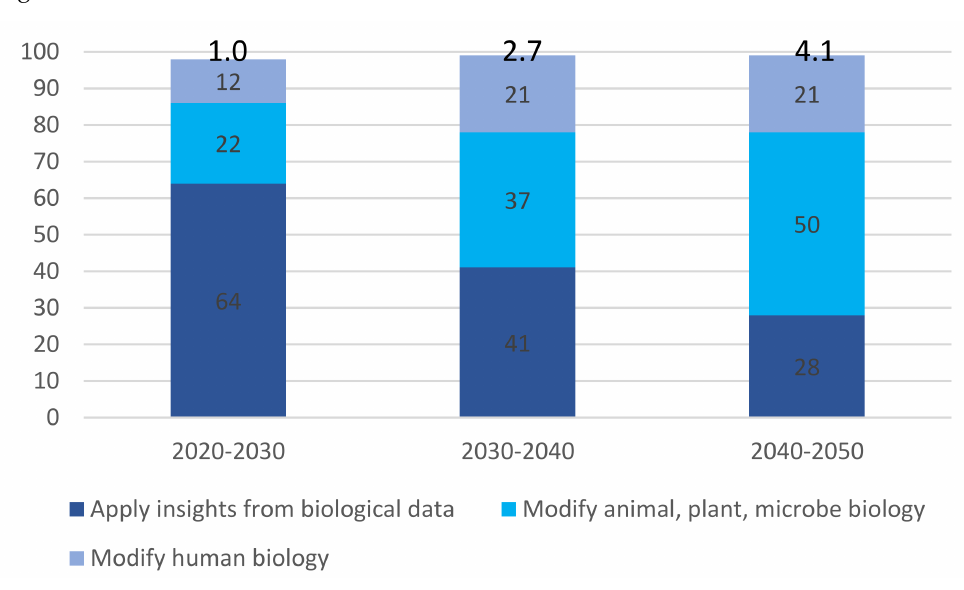
Figure 1. Estimated economic impact of the bio revolution in the near, medium and long term. Sized applications by technology platform (partial estimate). Adapted from